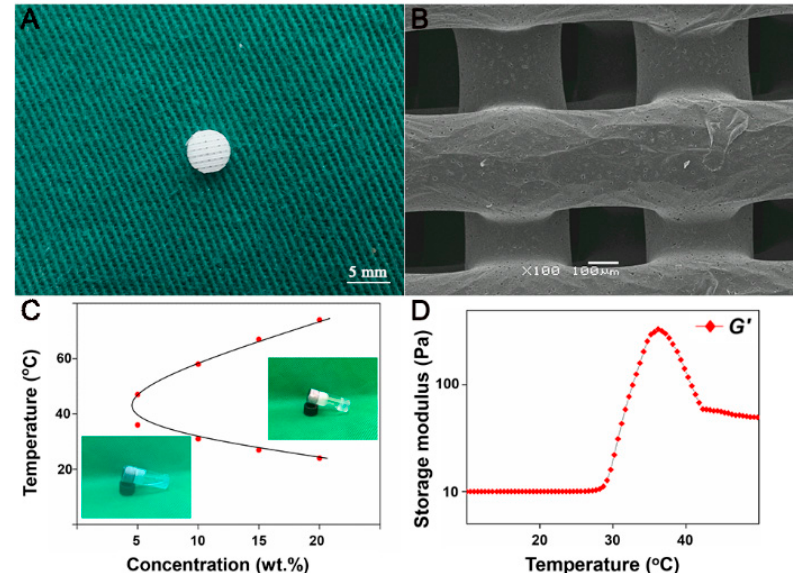
Figure 2. Characterization of PCL scaffold and PLGA–PEG–PLGA thermogel. Gross observation ( A ) and SEM image ( B ) of PCL scaffold fabricated by FDM. Sol-gel phase diagrams of PLGA–PEG–PLGA copolymer in PBS with different concentrations ( C ). Rheological study of PLGA–PEG–PLGA copolymer solution at a concentration of 20 wt % ( D